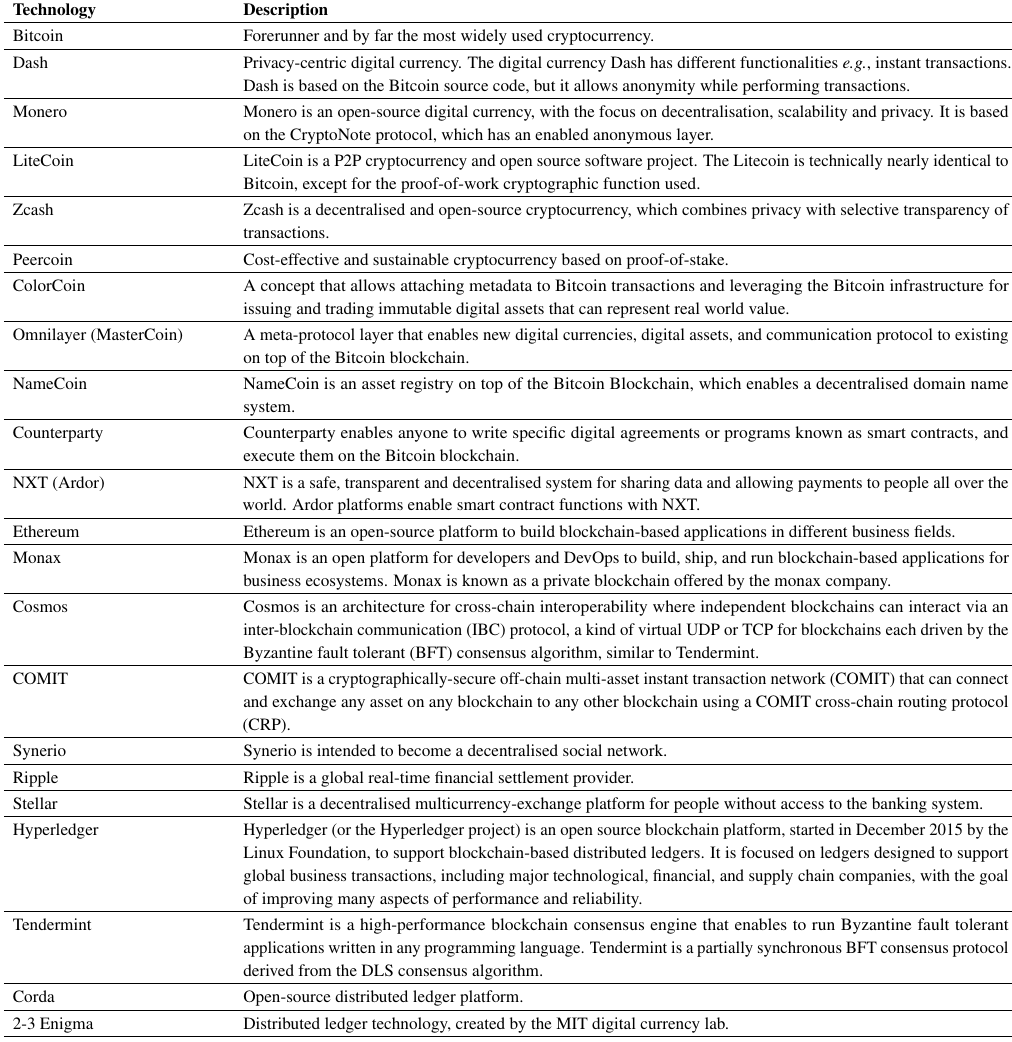
Table 1. Blockchain